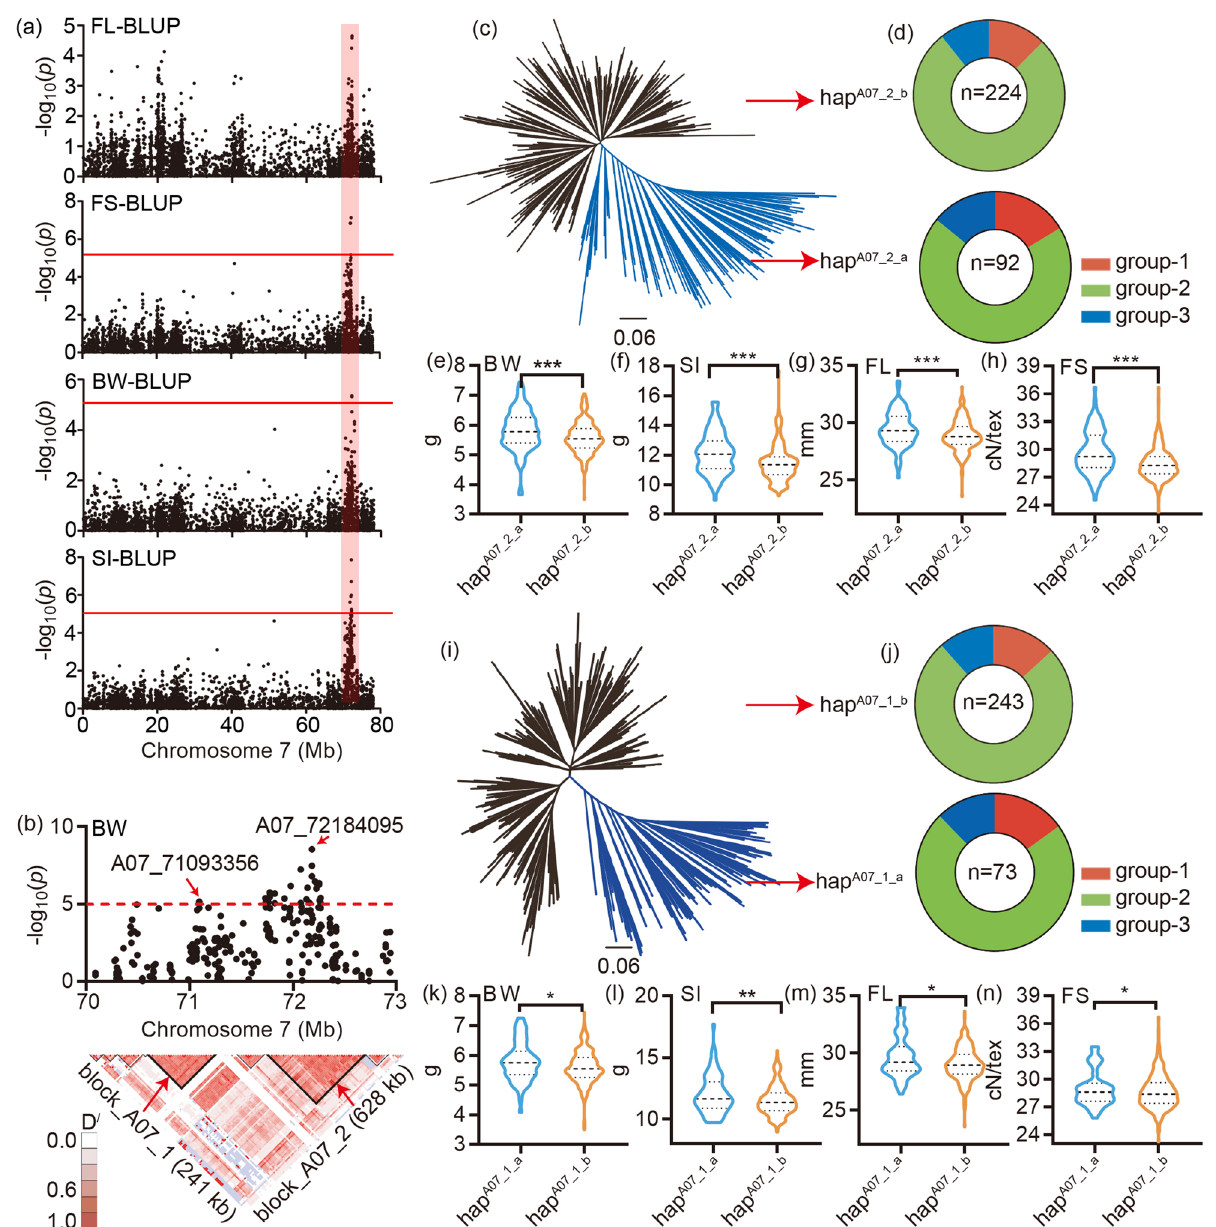
Figure 2. Identification and genotyping of the pleotropic region LD block 6 and 8 on chromosome A07: ( a ) The Manhattan block of the FL, SI, FS and BW, the red horizontal dashed lines indicate the significance threshold (− log 10 ( P ) > 5.27); the red box indicates the region identified by the GWAS of FL-blup, FS-blup, BW-blup and SI-blup, located between 70 to 73 Mb on A07 chromosome; ( b ) Local Manhattan block (top) and LD heat map (bottom). The red arrows indicate the most significance SNPs in the two LD blocks at the top and the location of the two LD blocks (block_A07_1 and block_A07_2) at the bottom; ( c ) A neighbor-joining tree was constructed using the SNP data located in the LD block 12. The accessions were divided into two haplotypes, hap A07_2_a and hap A07_2_b ; ( d ) The composition of the two haplotypes, group-1 (red), group-2 (cyan) and group-3 (blue); ( e – h ) Box plots for boll weight, length, strength and seed index for the two haplotypes (n = 92 and 224); ( i ) A neighbor-joining tree was constructed using the SNP data located in the LD block 10. The accessions were divided into two haplotypes, hap A07_1_a and hap A07_1_b ; ( j ) The composition of the two haplotypes, group-1 (red), group-2 (cyan) and group-3 (blue); ( k – n ) Box plots for boll weight, length, strength and seed index for the two haplotypes (n = 243 and 73). Center line, median; box limits, upper and lower quartiles. whiskers, 1.5× the interquartile range; dots, outliers (* P < 0.05, ** P < 0.01 and *** P < 0.001, two-sided t-test). The neighbor-joining tree ( c and i ) was constructed using the software PHYLIP (v3.696, https:// evolu tion. genet ics. washi ngton. edu/ phylip. html). The LD heatmap (the bottom of b ) was created by the Haploview software (https:// www. broad insti tute. org/ haplo view/ haplo view). The others were created by the software GraphPad Prism 9 (ver. 9.0.0, http:// www. graph pad.